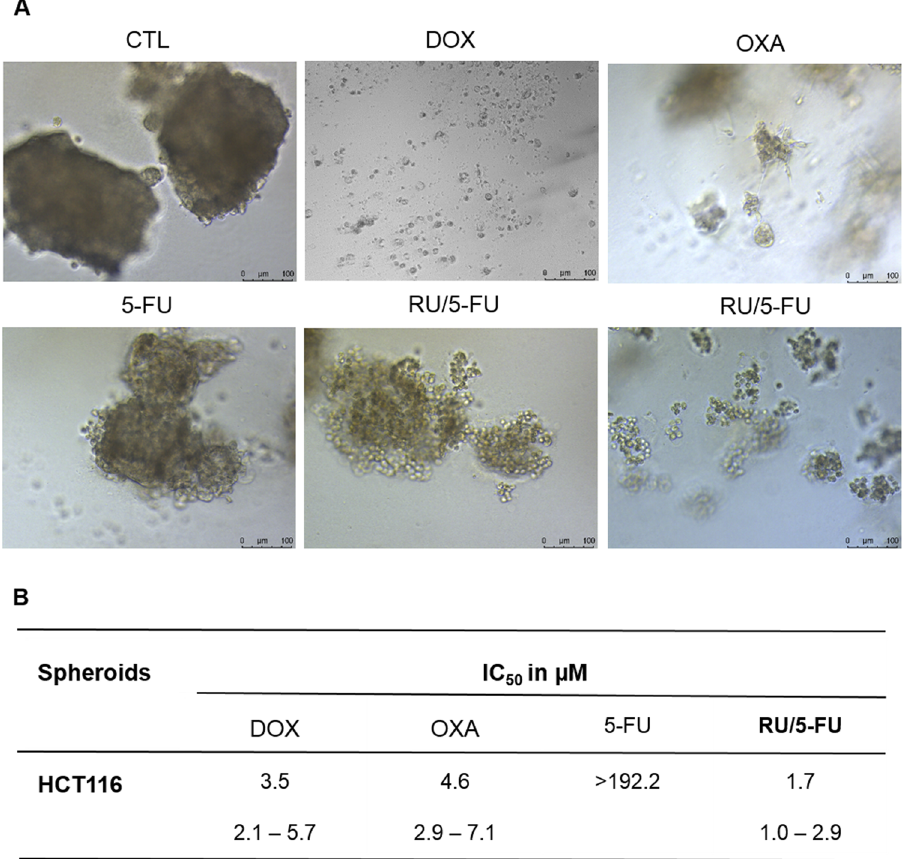
Figure 4. Effect of the complex [Ru(5-FU)(PPh 3 ) 2 (bipy)]PF 6 (RU/5-FU) in 3D in vitro model of cancer multicellular spheroids formed from HCT116 cells. ( A ) Cells examined by light microscopy (bar = 100 µ m). ( B ) IC 50 values in μ M and their respective 95% confidence interval obtained by nonlinear regression from three independent experiments performed in duplicate, measured by alamar blue assay 72 h after incubation. The negative control (CTL) was treated with the vehicle (0.1% DMSO) used for diluting the compound tested. Doxorubicin (DOX), oxaliplatin (OXA) and 5-fluorouracil (5-FU) were used as the positive